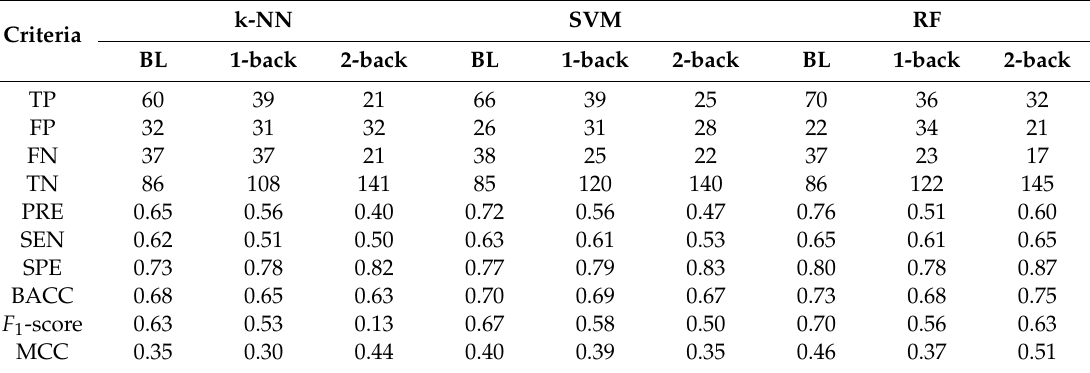
Table 4. Classification summary of multiclass classification for k-NN, SVM, and RF on the test dataset. Where the target classes are baseline (BL) or no-task, 1-back, and 2-back task. SEN: Sensitivity; SPE: Specificity; PRE: Precision; ACC: Accuracy; and BACC: Balanced